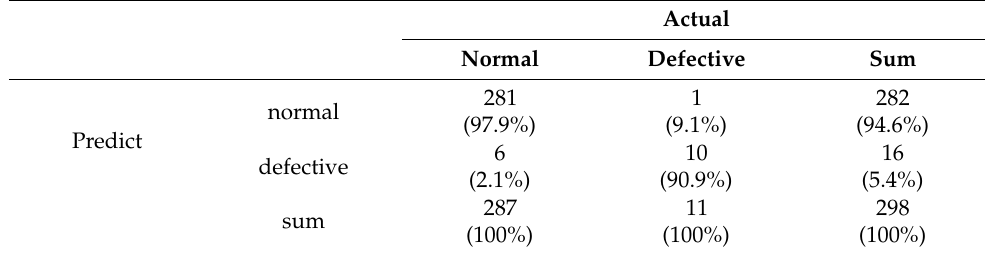
Table 5. Model accuracy confusion